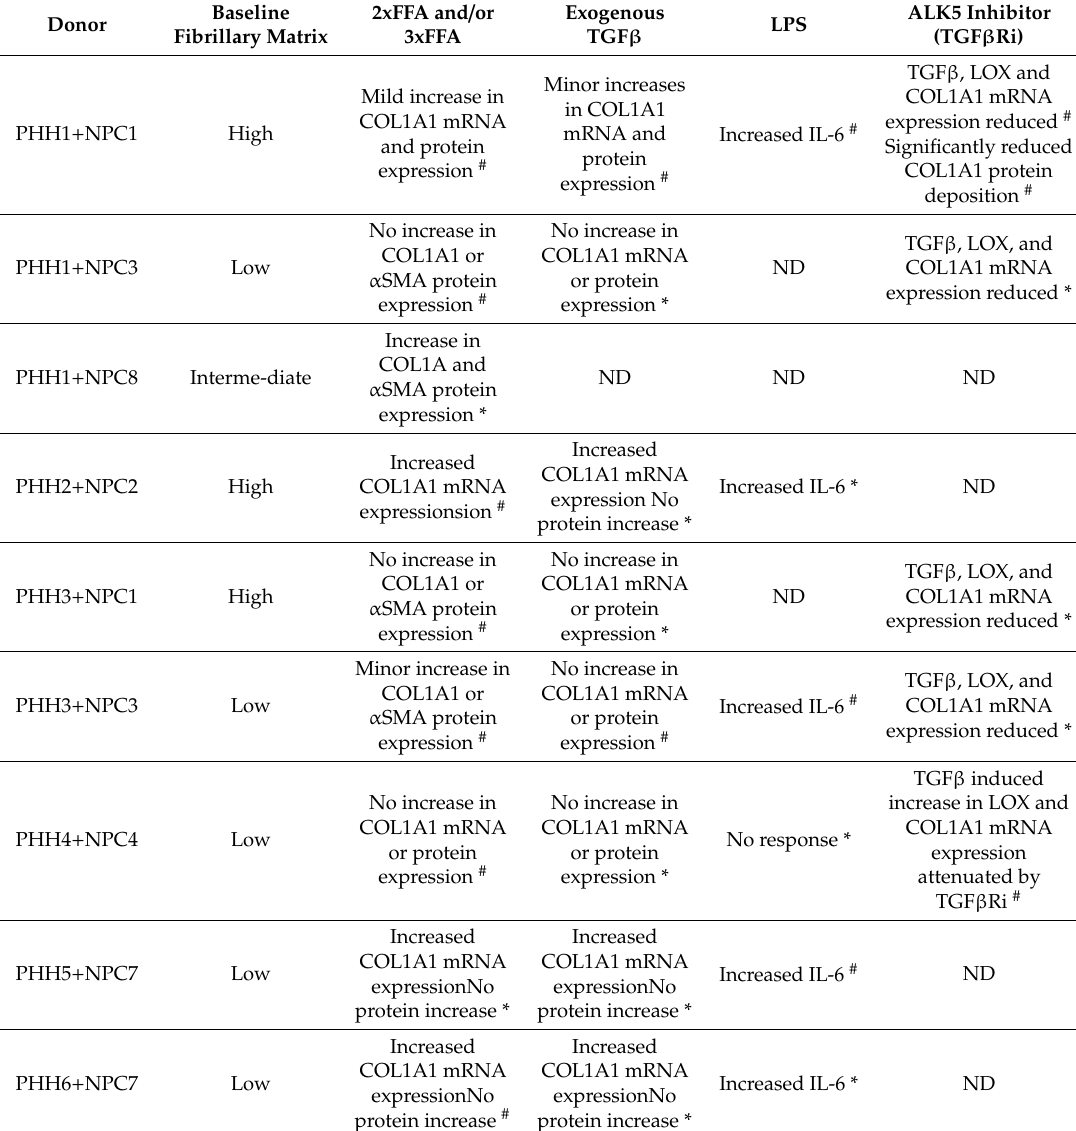
Table 2. Experiments conducted with various donor combinations and the